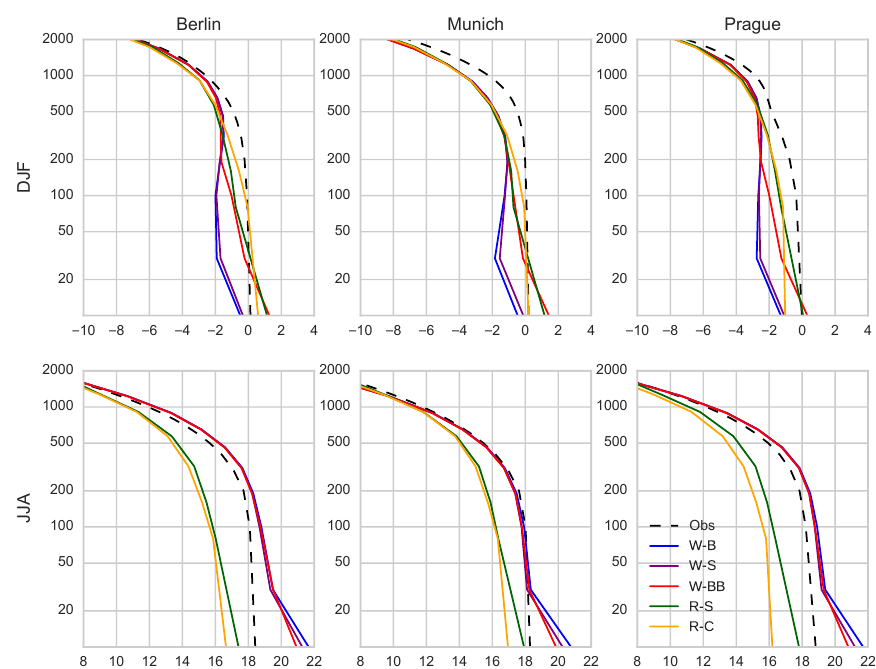
Figure 7. The averaged temperature vertical profiles (in ◦ C) over selected cities, given by models and radiosonde observations. The y axis indicates the altitude in metres.